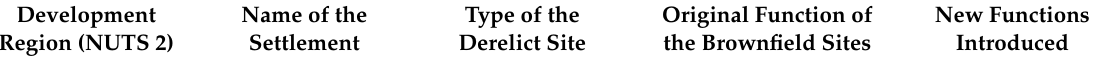
Figure 3. Rehabilitation types on NUTS 2 level (N = 64). Table 3. Redevelopment projects for diverse derelict sites.